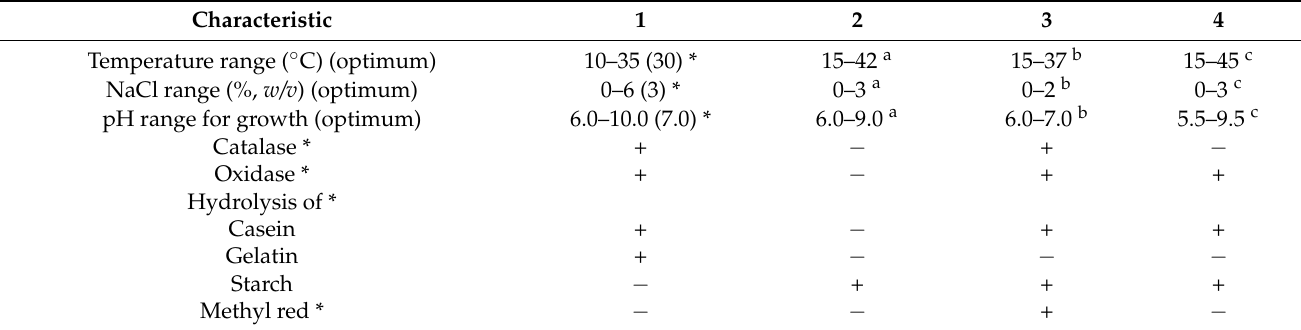
Table 1. Differential characteristics between strain KIGAM252 T and the type strains of closely related species in the genus Metabacillus (Taxa: 1, Strain KIGAM252 T ; 2, M. mangrovi AK61 T ; 3, M. indicus LMG 22858 T ; 4, M. idriensis SMC 4352-2 T ). All of the species were negative for the hydrolysis of Tween 20, 40, and 80 and Voges-Proskauer test. All of the species gave positive results for β -glucosidase, protease, and β -galactosidase, but negative results for reduction of nitrate to nitrite, reduction of nitrite to nitrox- ide, indole production, glucose fermentation, arginine dihydrolase, and urease in the API 20NE test. All of the species gave positive results for alkaline phosphatase, esterase lipase (C8), leucine arylami- dase, naphthol-AS-BI-phosphohydrolase, α -galactosidase, β -galactosidase, and α -glucosidase, but negative results for β -glucuronidase, N -acetyl- β -glucosaminidase, α -mannosidase, and α -fucosidase in the API ® ZYM test. All of the species gave positive results for glycerol, D-galactose, D-glucose, D-fructose, esculin, D-maltose, and D-raffinose, but negative results for erythritol, D-arabinose, L-arabinose, L-xylose, D-adonitol, methyl- β -D-xyloside, L-sorbose, L-rhamnose, dulcitol, xylitol, D-lyxose, D-tagatose, D-fucose, L-fucose, D-arabitol, L-arabitol, gluconate, and 5-ketogluconate